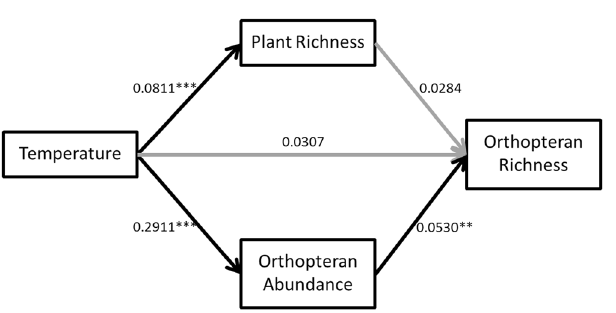
Figure 4. Structural equation model for the alternative mechanisms of cross-taxon congruence between orthopteran and plant richness. We show standardized partial regression coefficients and their significance levels (**p > 0.01; ***p > 0.001) shown above the arrows. Black arrows represent significant